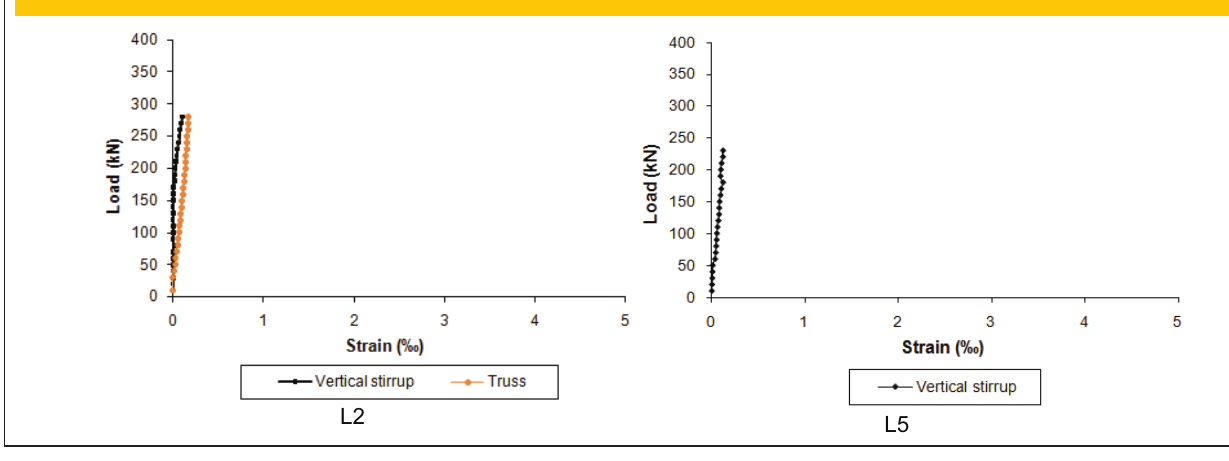
Figure 15 – Slabs L2 and L5 shear reinforcement in the ribs strains